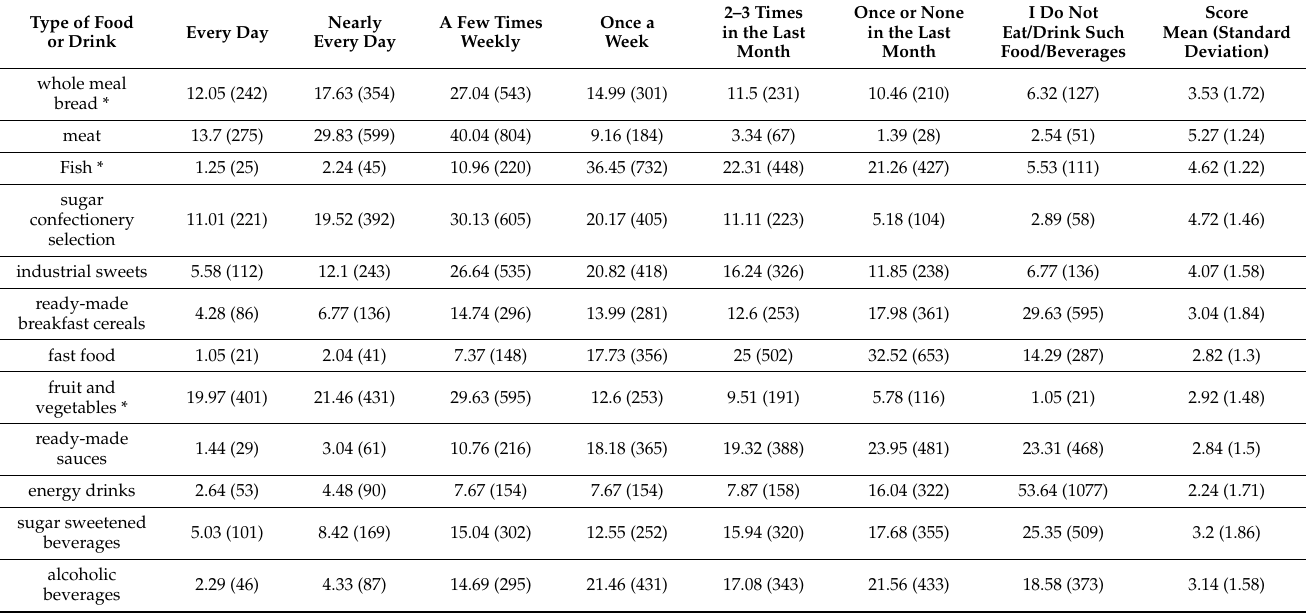
Table 2. The results of the assessment of the frequency of the consumption of selected food and